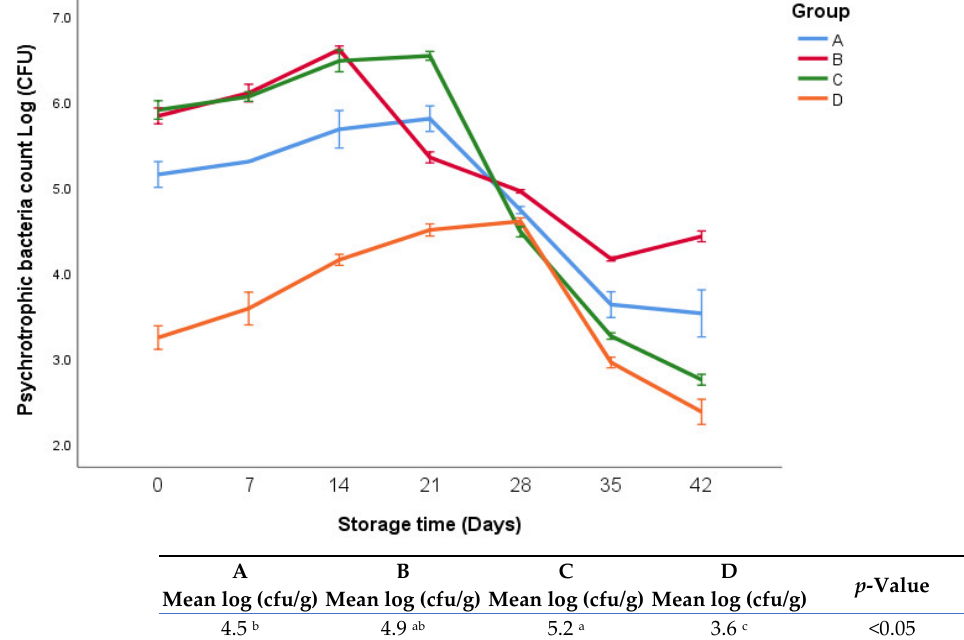
Figure 5. Psychrotrophic bacterial count of fresh oregano samples at refrigerator temperature 4 °C. The significant differences ( p < 0.05) between means are indicated in different letters in the same row. The effect of treatments was pooled to consider the whole storage period and the means were separated by Duncan test. The growth of yeast and mold in fresh oregano leaves at a refrigerator temperature 4 °C is shown in Figure 6. In general, there were no significant differences in yeast and mold counts during the whole period of storage for all groups.